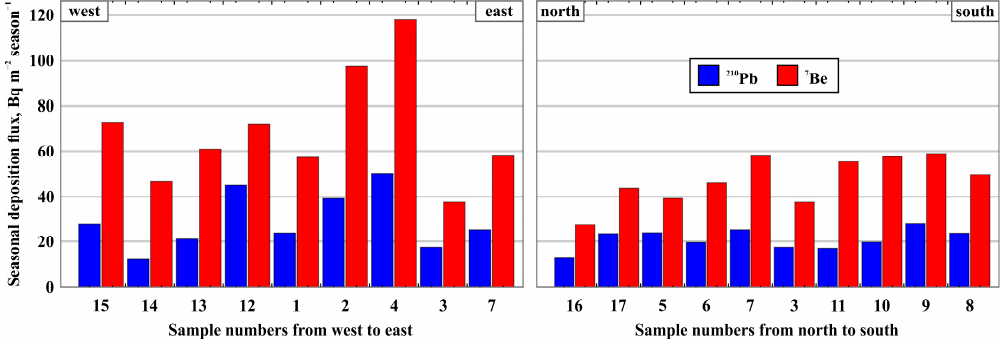
Figure 4. Spatial distribution of 7 Be and 210 Pb atm seasonal deposition fluxes at sampling points.